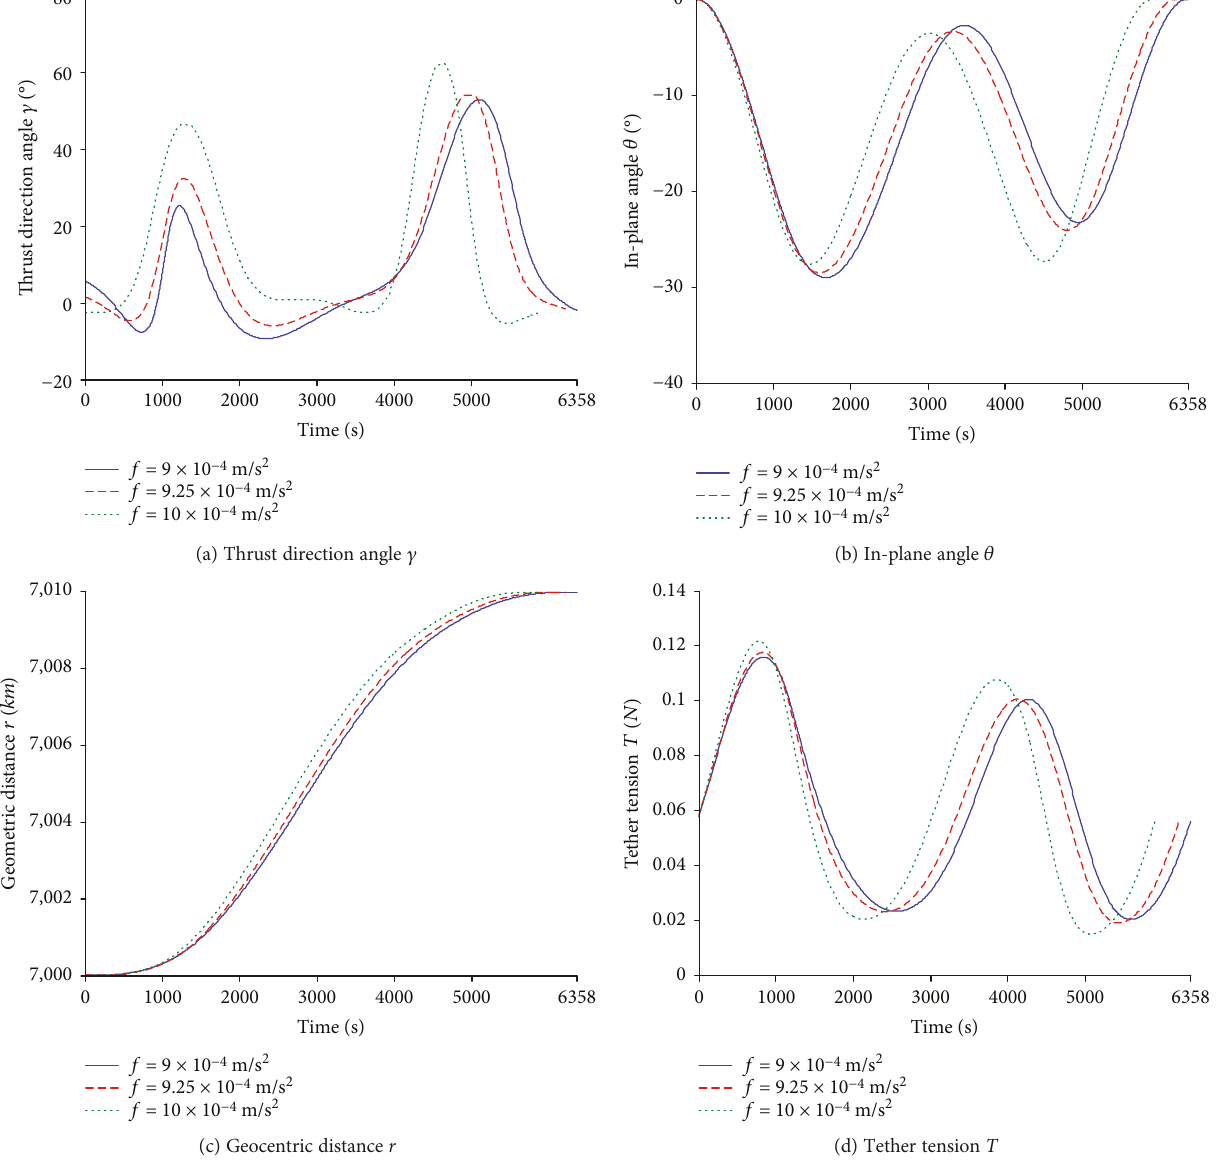
Figure 6: Time responses of the tethered system with di ff erent thrust